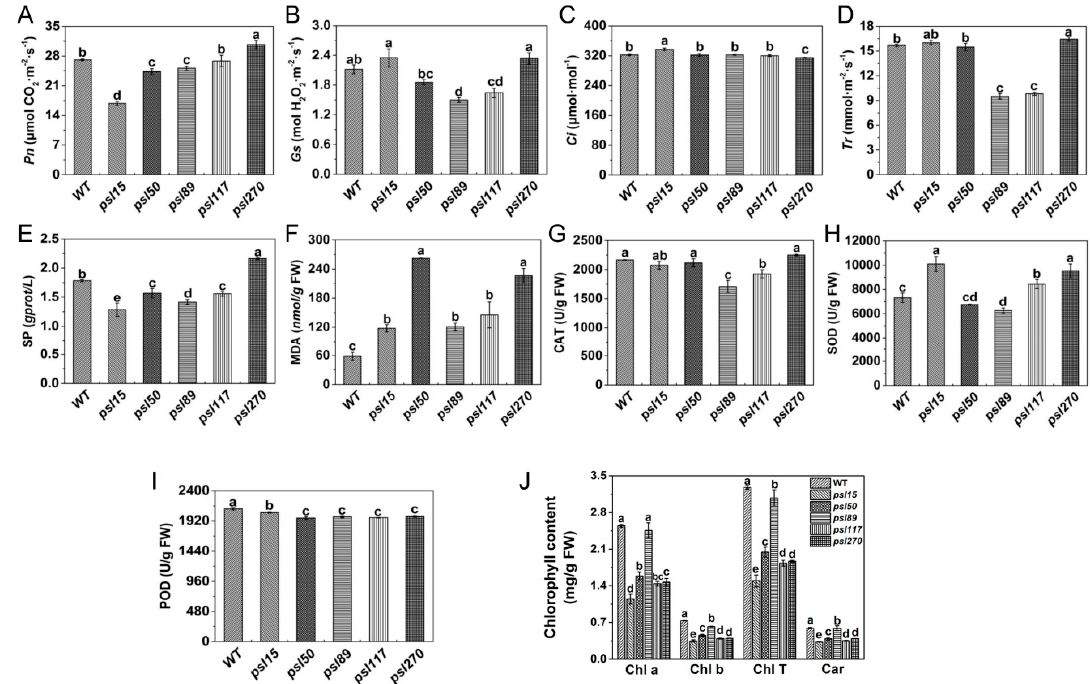
Figure 2. Photosynthetic and senescence-related parameters of WT and mutants. ( A ) Net photosynthetic rate ( Pn ); ( B ) stomatal conductance ( Gs ); ( C ) transpiration rate ( Tr ); ( D ) intercellular CO 2 concentration ( Ci ); ( E ) soluble proteins (SP) content; ( F ) malonaldehyde (MDA) content. ( G ) Catalase (CAT) activity; ( H ) superoxide dismutase (SOD) activity; ( I ) peroxidase (POD) activity; ( J ) Contents of photosynthetic pigments. Chl a, chlorophyll a ; Chl b, chlorophyll b ; Chl T, total chlorophyll; Car, carotenoid. All experiments were carried out using flag leaves at the heading stage. Error bars indicate Mean ± SD ( n = 3). Different letters indicate a statistical difference at p ≤ 0.05 by Duncan’s test.